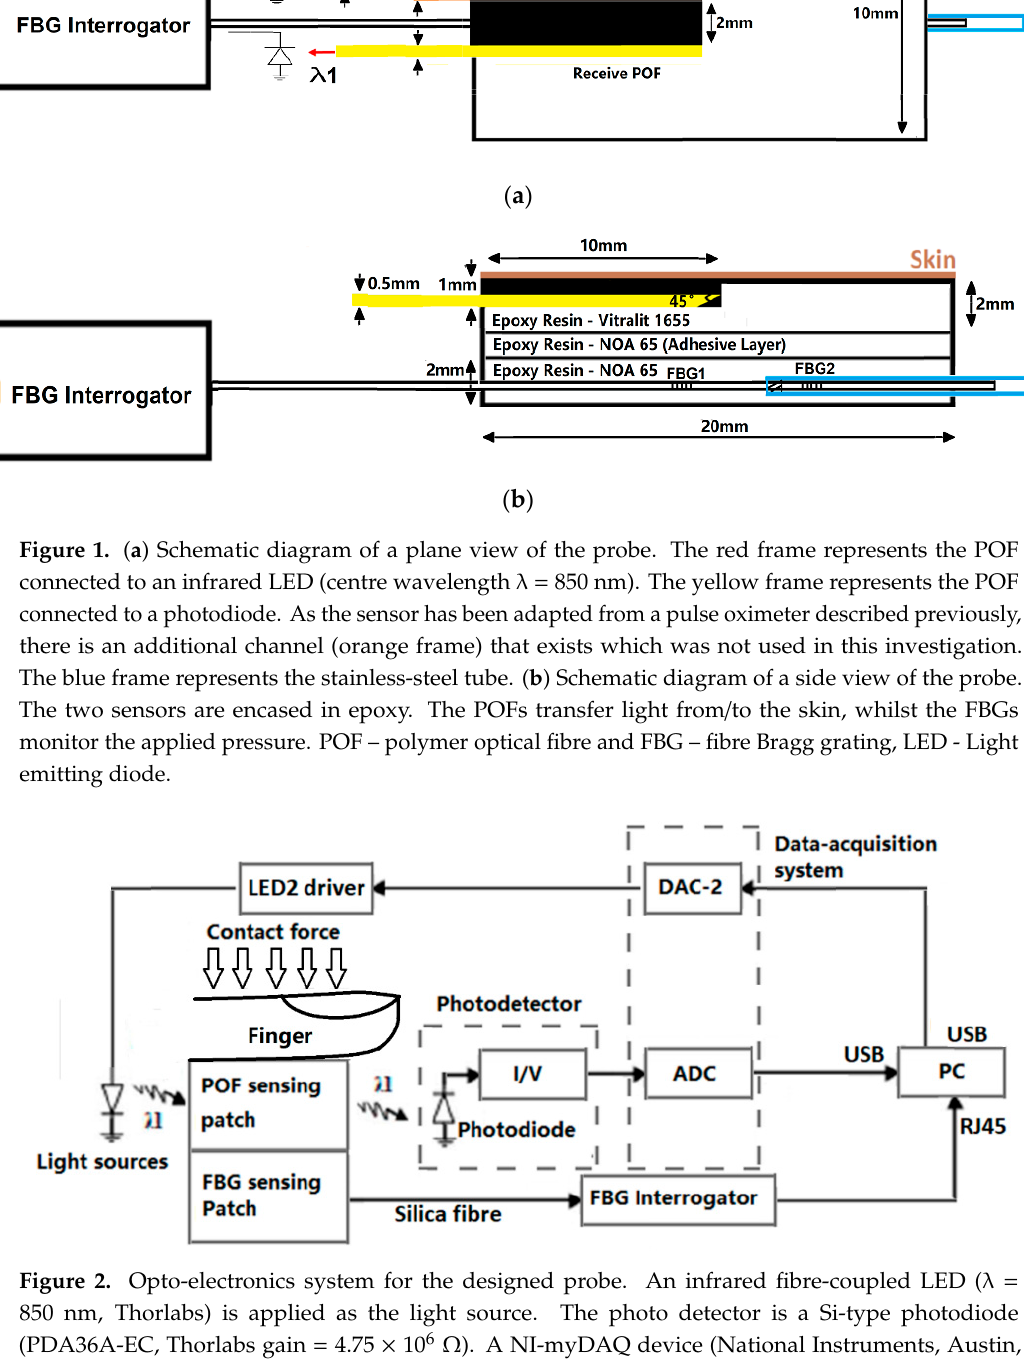
Figure 2. Opto-electronics system for the designed probe. An infrared fibre-coupled LED ( λ = 850 nm, Thorlabs) is applied as the light source. The photo detector is a Si-type photodiode (PDA36A-EC, Thorlabs gain = 4.75 × 10 6 Ω ). A NI-myDAQ device (National Instruments, Austin, TX, USA) was applied, as the data acquisition system in the opto-electronics system had a +/ − 10 V 16-bit analogue-to-digital converter (ADC). The FBG interrogator is a SmartScope FBG interrogator (0.8 pm resolution). (I/V: current-to-voltage converter; DAC: digital-to-analogue converter; ADC: analogue-to-digital converter; and PC: personal computer).